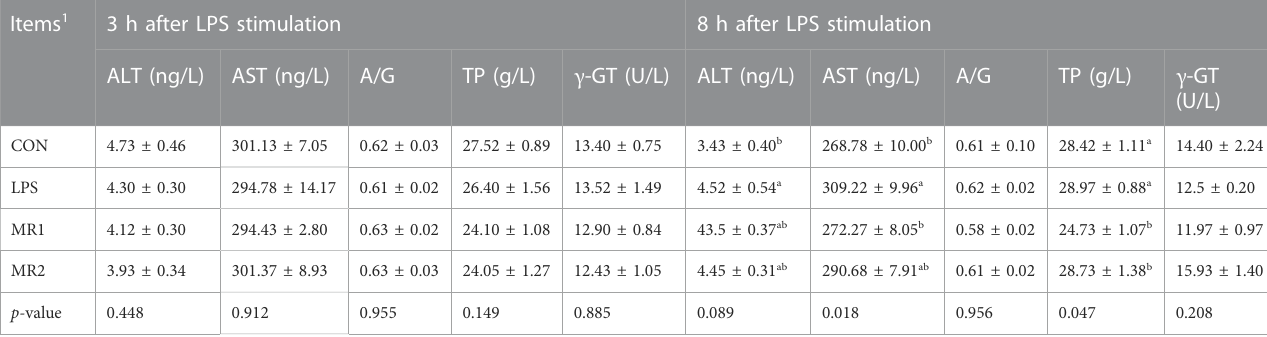
TABLE 5 Effects of dietary methionine restriction on serum biochemical parameters of LPS-stimulated broilers (n = 6). Items 1